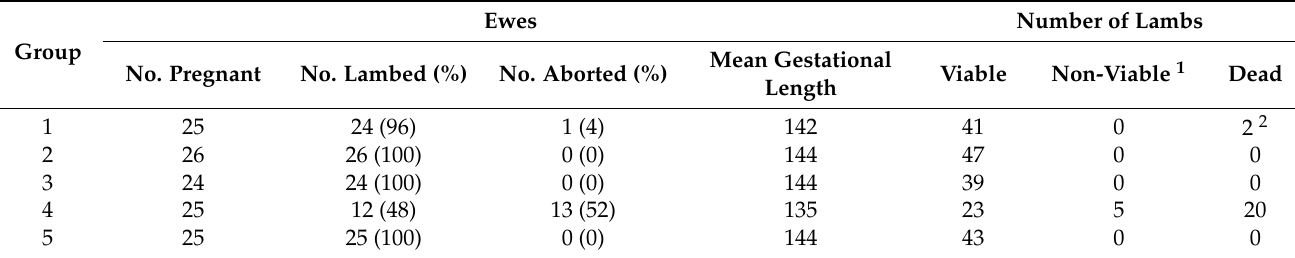
Table 1. The clinical outcome of pregnancy in vaccinated ewes that were subsequently challenged with Chlamydia abortus at day 70 of gestation (groups 1–3), in infected control ewes (group 4), or in uninfected control ewes (group 5).